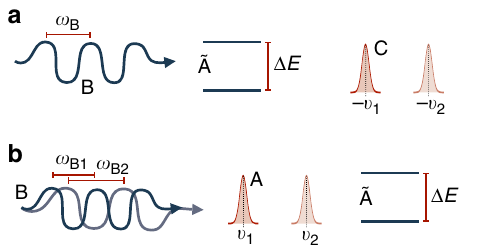
Fig. 8 Transformation to the rest frame of a quantum system. The interaction between a photon B and the internal degrees of freedom Ã of an atom as described from the point of view of a the rest frame of the atom A itself and b the laboratory C. We consider the situation when the atom does not have a sharp momentum in the laboratory reference frame and calculate which state of the photon and the atom we have to prepare to maximise the probability of absorbing the photon. The description of the situation is simplest in the rest reference frame ( a ). If the photon has Δ E ’ s energy gap, the spectral frequency ω (cid:2) h corresponding to the atom B ¼ probability is maximised. For simplicity of illustration, the state of the laboratory is described as a superposition of two amplitudes sharp around the velocities − v 1 and − v 2 . From the point of view of C, this situation is described as in b , in which the state of the photon and the external degrees of freedom of the atom are entangled. For each velocity v i , i ¼ 1 ; 2 of atom (cid:4) ω A, the frequency of the photon is Doppler-shifted as: ω 1 (cid:2) v i B i ¼ B c i ¼ 1 ; 2. The measurement of the frequency ^ ω in A ’ s reference frame, B in the corresponds to the measurement of the observable ^ ω 1 þ ^ p A B cm A laboratory reference frame (see the next section). This ensures that if the photon is found absorbed ( ‘ detected ’ ) by the atom in its RF, so it will in the laboratory